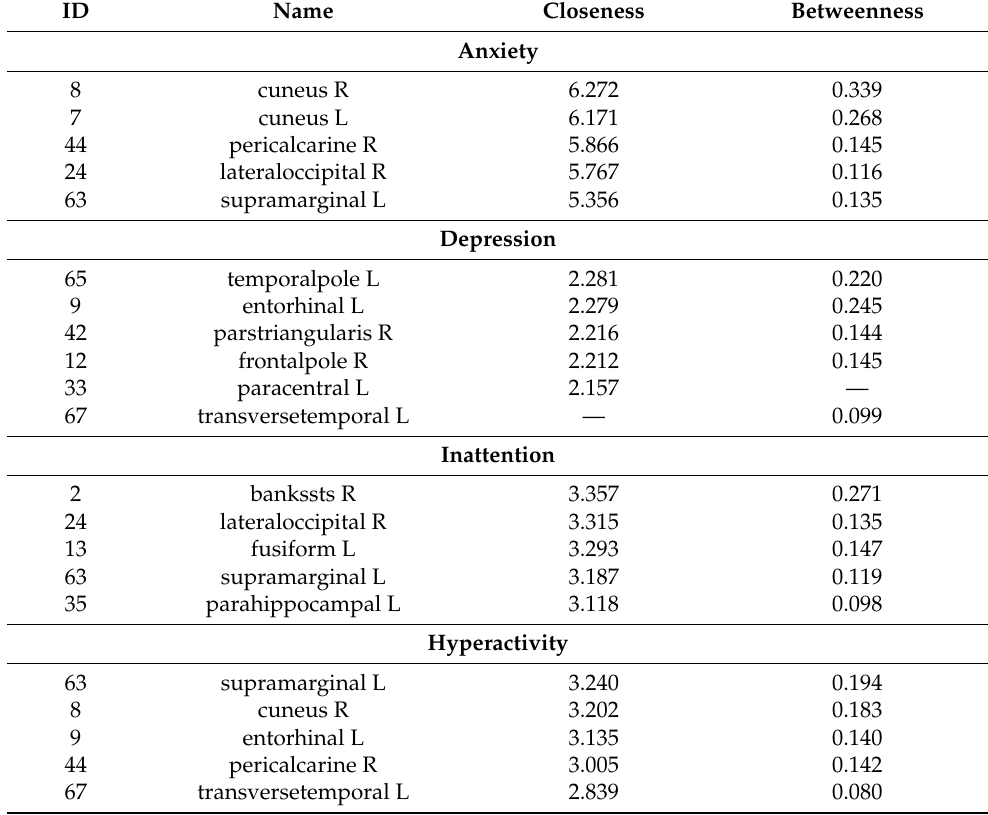
As shown in Figure 5, a small number of graph vertices (ROIs) dominate for predicting each mental health symptom. Table 2 shows these high-strength or highest-contributing vertices (ROIs) and their corresponding brain regions. Table 2. ROIs with top 5 centrality scores. Top 5 ROIs in terms of two types of centralities (closeness centrality and betweenness centrality) for each mood symptom. The values of centrality are computed based on weighted graphs in which vertices, edges, and weights correspond to ROIs, a pair of ROIs, and chi-square statistic of augmented features consisting of two ROIs of two original